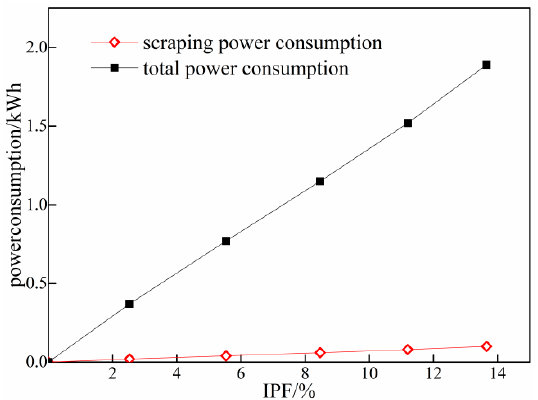
Figure 7. Relationship between IPF and power consumption (3% wt NaCl solution).